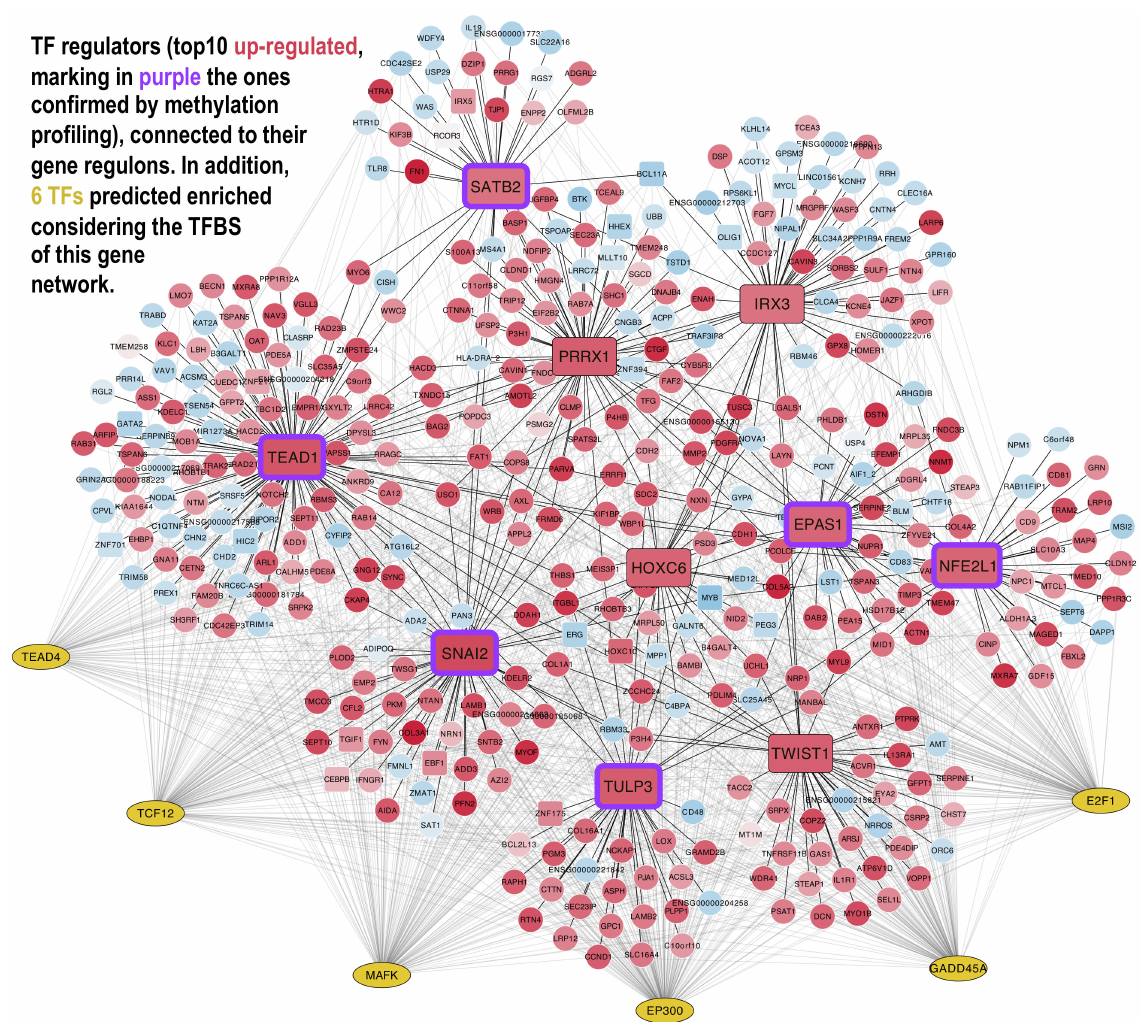
Figure 5. Gene co-regulation network presenting the top 10 upregulated master regulators (red rectangles): The master regulators are connected with their regulons that are the gene sets that each one regulates: Upregulated genes have a red background, while downregulated genes have a pale blue color. The 6 TFs (E2F1, EP300, GADD45A, MAFK, TCF12, and TEAD4) included in yellow ellipses